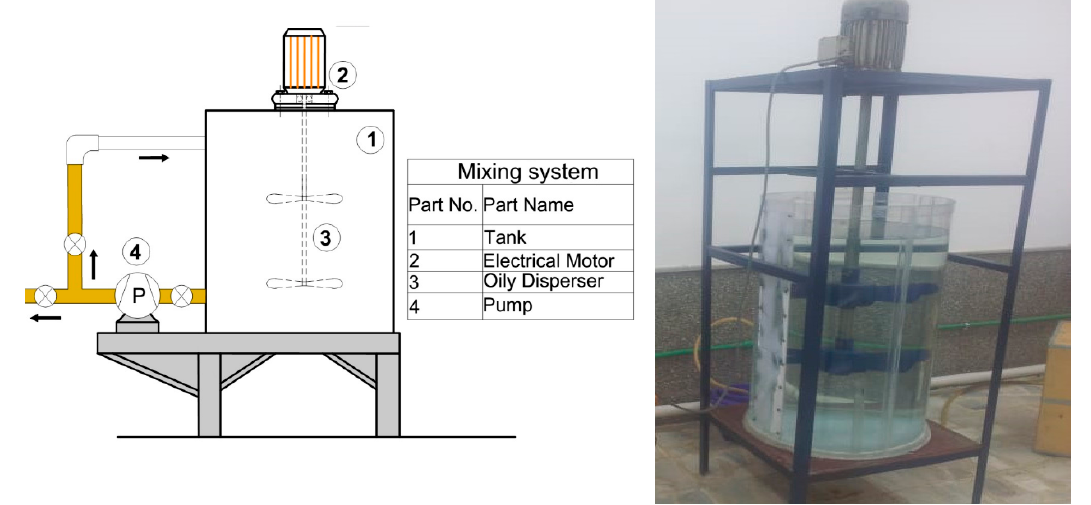
Figure 1. Mixing tank for preparation of nano-emulsion oil in water.